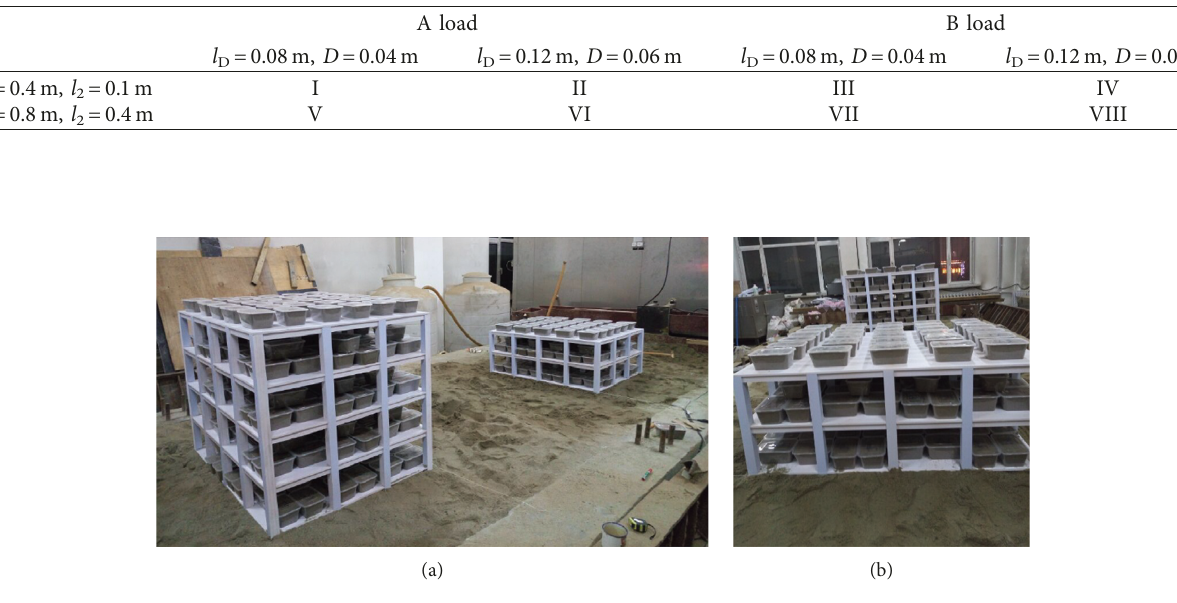
Figure 9: Existing building models with load